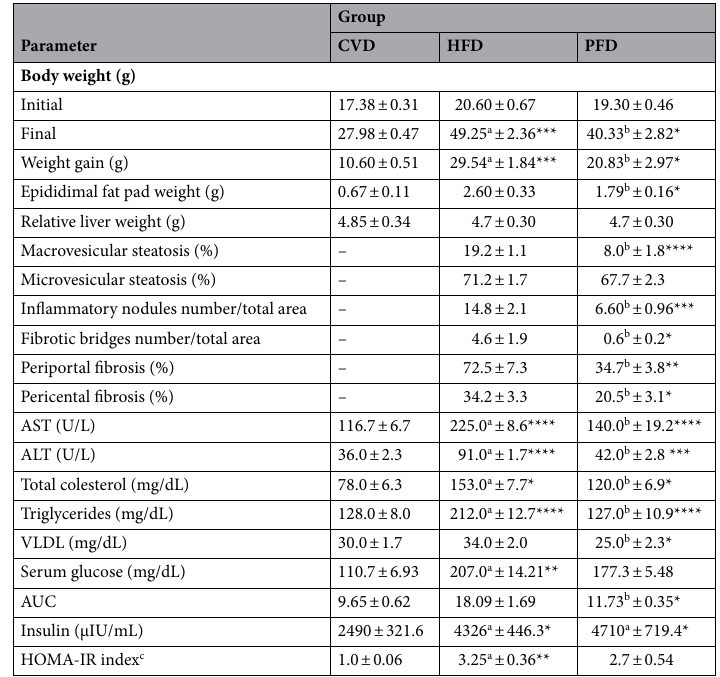
Table 1. Clinical, histological and biochemical parameters in animal groups. Data are expressed as mean ± SEM. CVD conventional diet, HFD high fat and high carbohydrate diet, PFD high fat diet + prolonged release pirfenidone. VLDL very low-density lipoproteins. a Significance difference versus CVD group (*p <